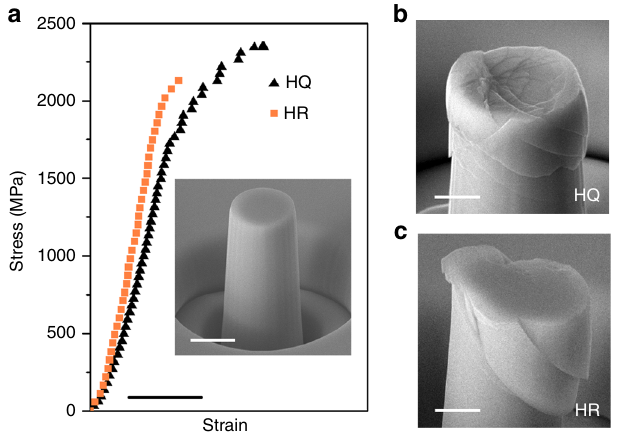
Fig. 3 Micro-pillar compression testing. a Engineering stress – stain curves of the hyper-quenched and the highly relaxed samples subjected to the uniaxial micro-pillar compression. Scale bar, 2%. The micro-pillars after deformation for b the hyper-quenched and c the highly relaxed samples. Scale bar, 1 μ m. The inset is a micro-pillar before compression. Scale bar,